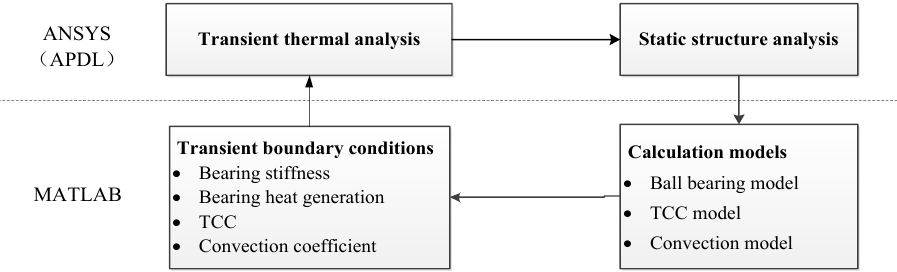
Figure 2. Solution